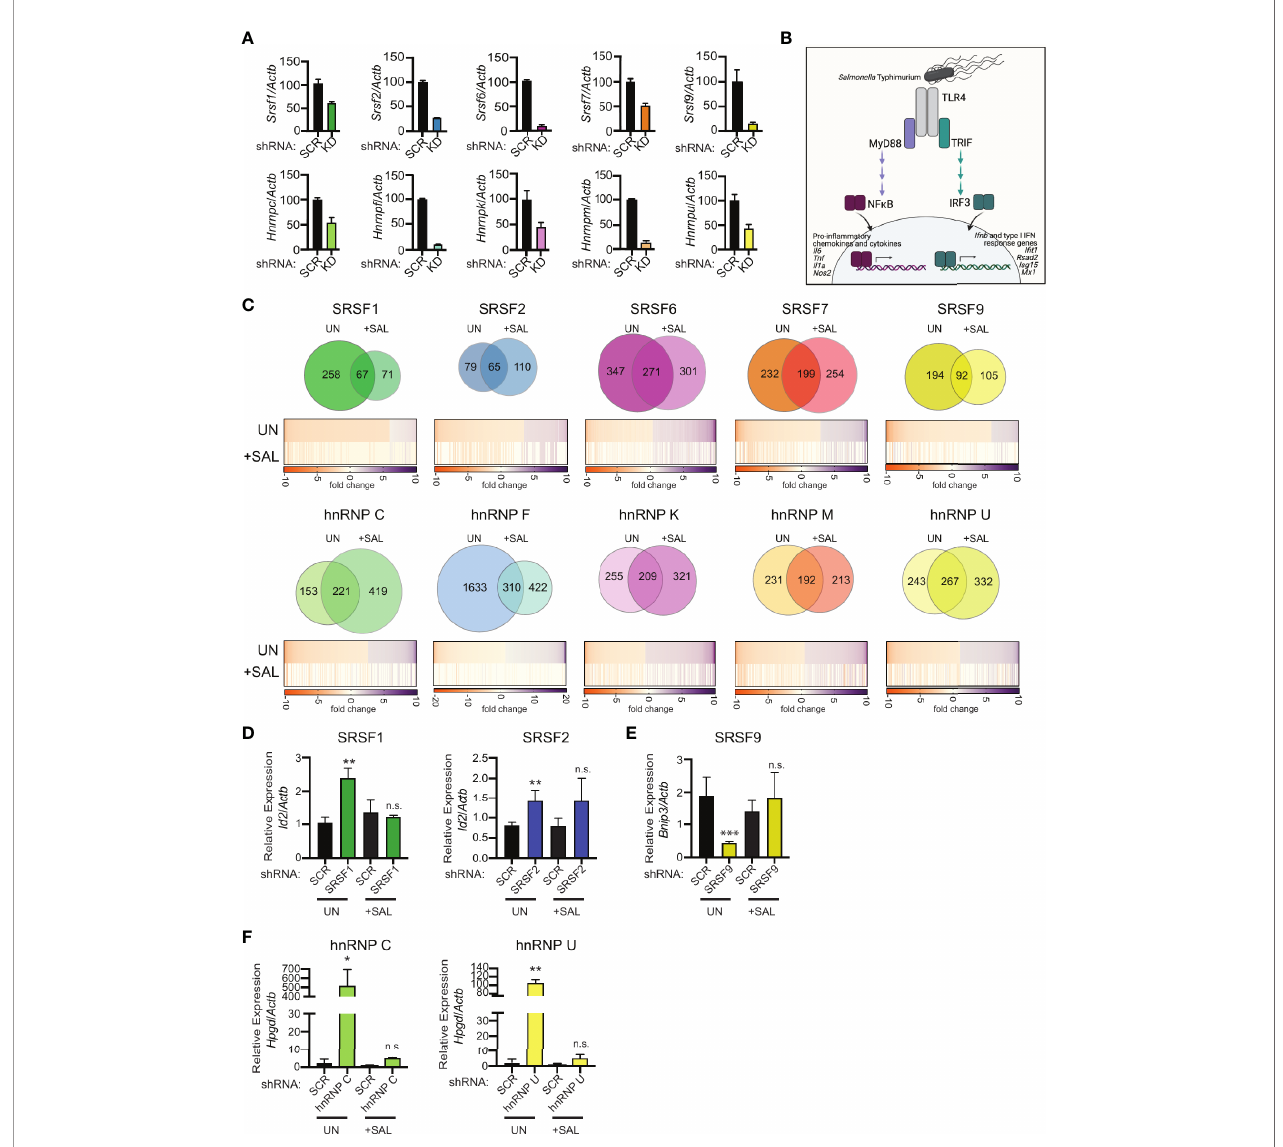
FIGURE 1 | RNA-Seq reveals distinct hnRNP- and SRSF-dependent regulons in uninfected and Salmonella -infected RAW 264.7 macrophages. (A) Knockdown ef fi ciency for each SR and hnRNP factor as measured by RT-qPCR. Data is shown as hnRNP/SRSF expression, relative to Actb , compared to SCR control cells. Ratios are the mean of 3 biological replicates and error bars show standard deviation. (B) Schematic representation of transcription factor activation downstream of Salmonella Typhimurium sensing by TLR4. (C) (Top) Overlap of differentially expressed genes (DEGs) between uninfected and Salmonella -infected RAW 264.7 macrophages (4h post-infection; MOI = 10) via Venn Diagram. (Bottom) Heatmaps of up and down-regulated DEGs from uninfected macrophages (UN). The values of the same genes in Salmonella -infected macrophages are shown below, with “ blank spots ” indicating DEGs that are not signi fi cantly changed in Salmonella -infected SR/hnRNP knockdown cell lines (+SAL). Orange represents genes downregulated in knockdown vs. SCR; purple represents genes upregulated in knockdown vs. SCR (colorbar shown below). DEGs were de fi ned as having a statistically signi fi cant fold-change relative to SCR; p<0.05. (D) Relative gene expression of Id2 over Actb in uninfected (UN) and Salmonella -infected (+SAL) SRSF1 and SRSF2 knockdown macrophage cell lines. (E) As in (D) but for Bnip3 expression in SRSF9 knockdown macrophages. (F) As in (D) but for Hpgd in hnRNP C and hnRNP U knockdown macrophages. For D-F RT-qPCRs, values are the mean of 3 biological replicates and error bars indicate standard deviation. *p < 0.05; **p < 0.01; ***p < 0.001; n.s, not statistically signi fi cant (p > 0.05). (B) was created using